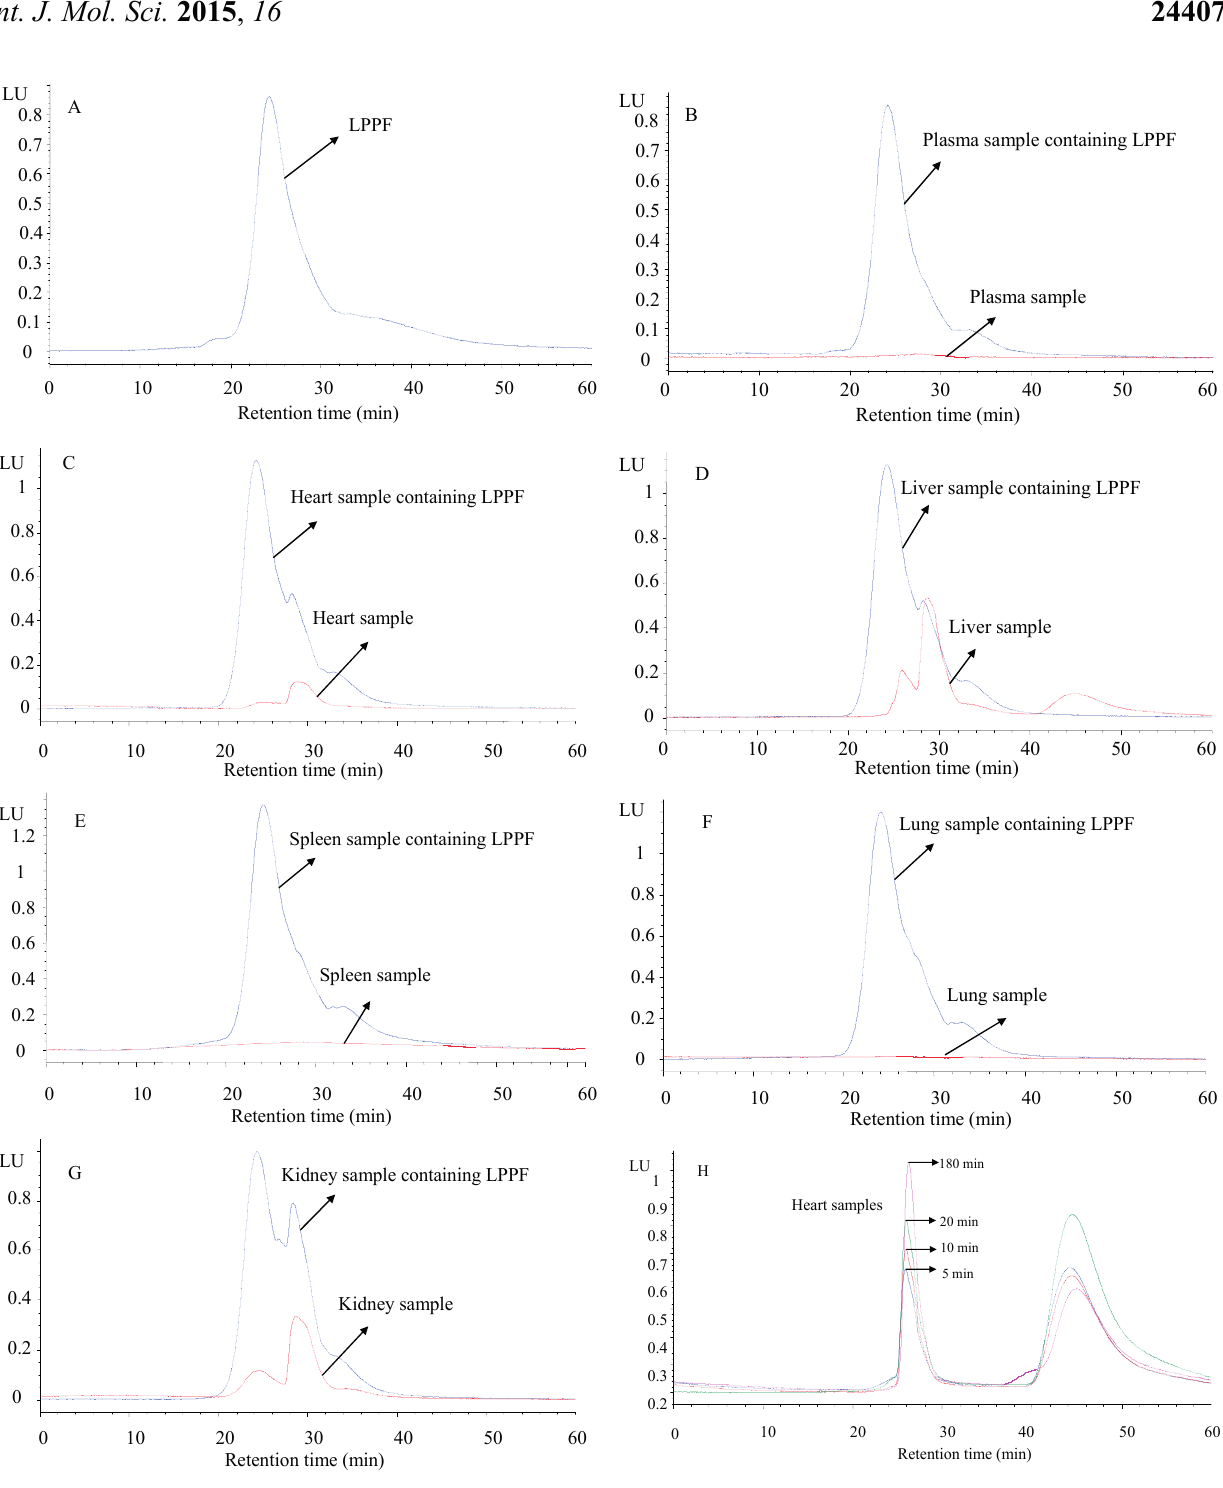
Figure 4. High performance size exclusion chromatograms of LPPF obtained by FD. ( A ) The chromatogram of 50 µg/mL LPPF prepared by phosphate buffer (pH 7.4); ( B – G ) The chromatograms of biological samples mixed with or without 50 µg/mL LPPF; ( H ) The chromatograms of heart samples from mice at predefined times (5, 10, 20 and 180 min) after a single intravenous (i.v.) administration of LPPF (40 mg/kg body